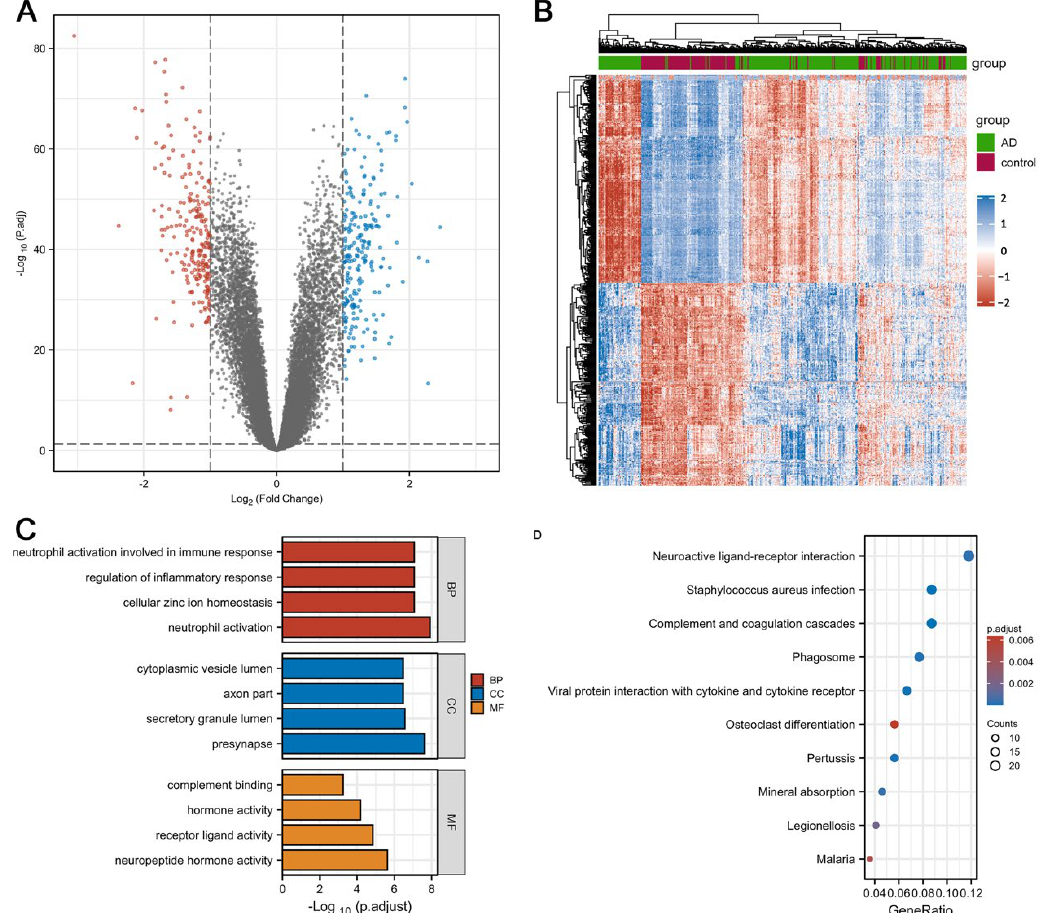
Figure 2. Differentially Expressed Genes and Enrichment Analysis. ( A , B ) Volcano map and heatmap of DEGs. ( C , D ) GO and KEGG enrichment analysis of DEGs.